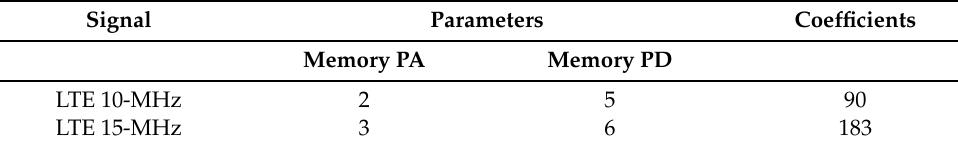
Table 1. Parameters summary for the PA extraction and PD prediction with CS model.